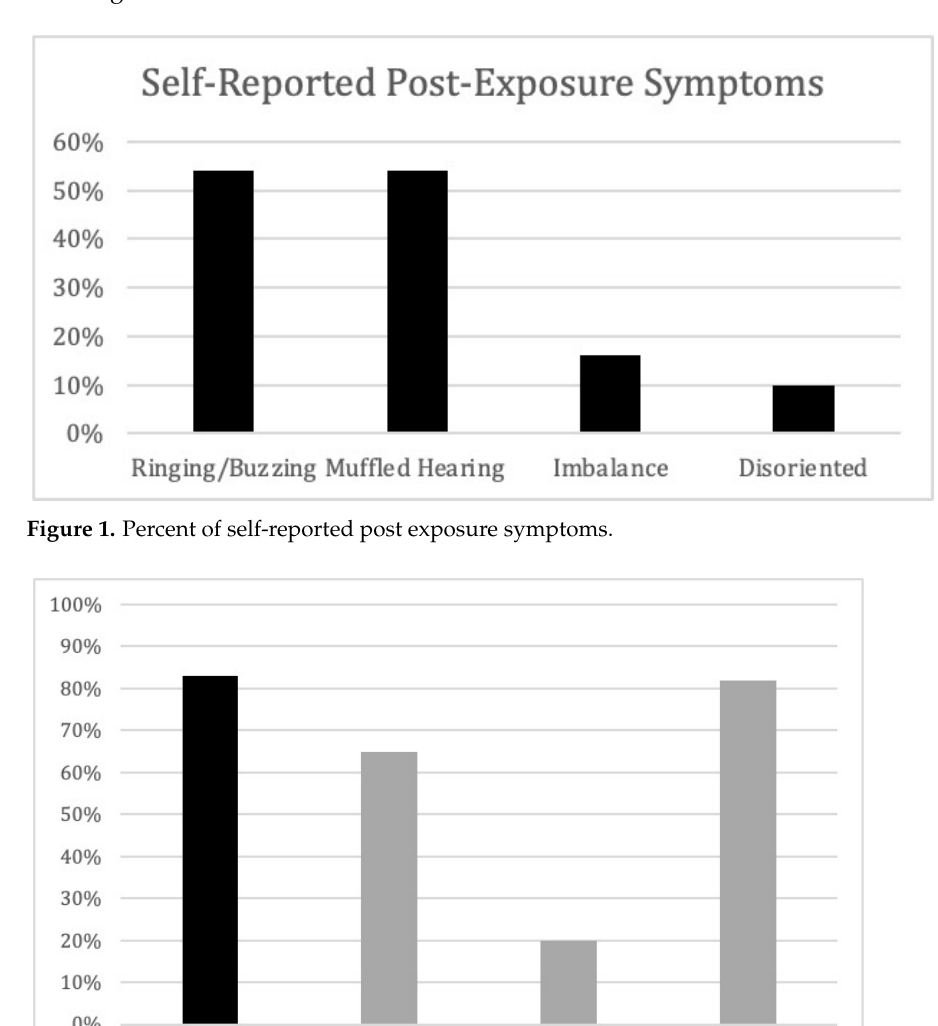
Figure 1. Percent of self-reported post exposure symptoms.